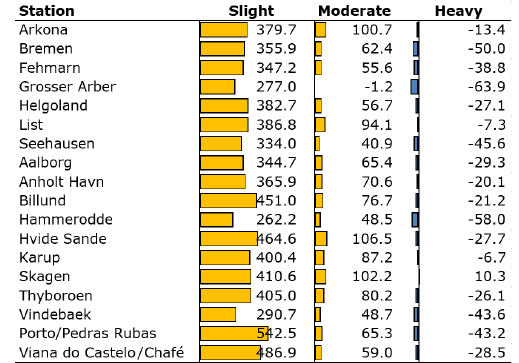
Figure 9. Relative biases (RBs) of the rainfall intensity (mm) for different categories of precipitation (Met Office, 2012): slight ( < 0 . 5mmh − 1 ), moderate (0.5–4mmh − 1 ), and heavy ( ≥ 4mmh − 1 ). The orange color indicates overestimation and the blue color under- estimation of rainfall intensities by IMERG with respect to the in situ